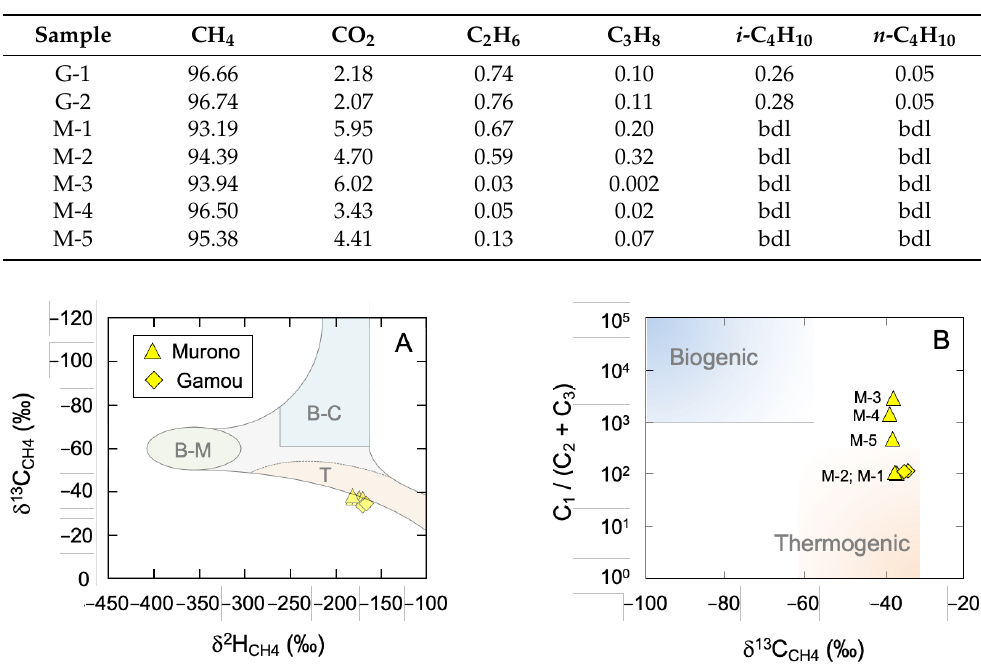
Table 1. Chemical composition (in %) of the major constituents of gas samples from Murono (M) and Gamou (G) samples. “bdl” = below detection limit.